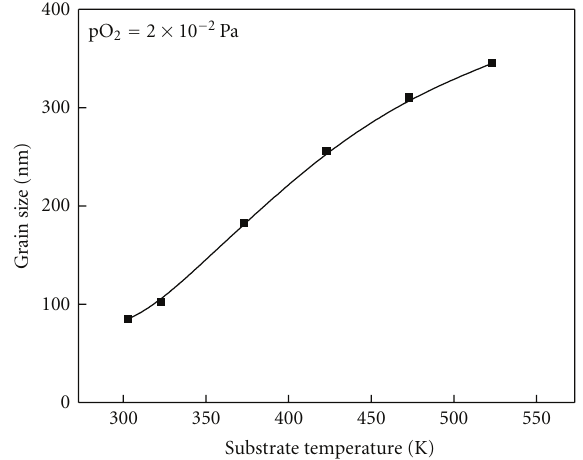
Figure 6: Variation in grain size of Ag-Cu-O films with substrate